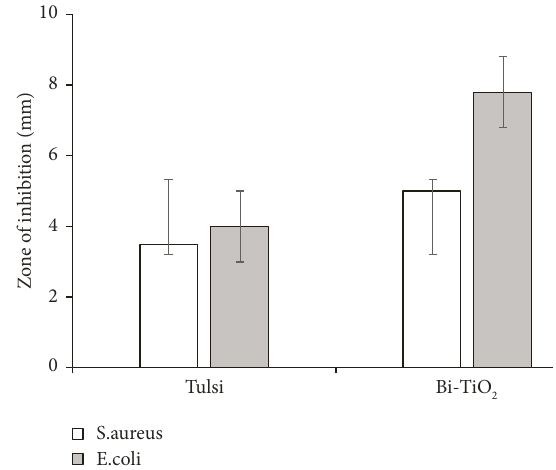
Figure 7: Antibacterial activity of Bi-TiO Ocimum sanctum leaf extract over Gram-positive and Gram- negative